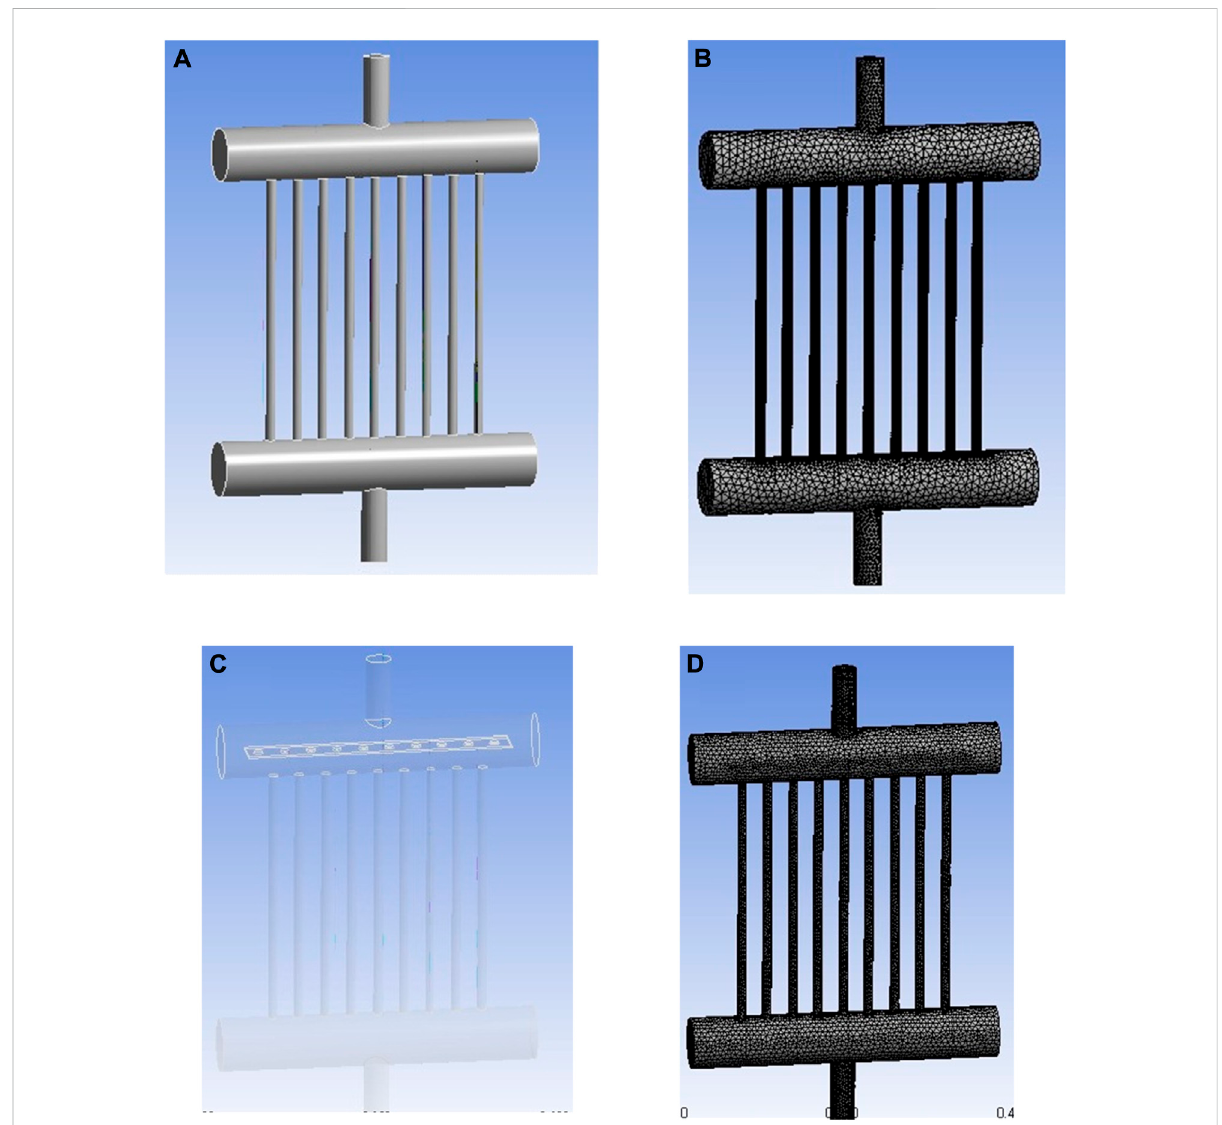
FIGURE 3 Geometry and mesh of header tube assemblies. (A) Geometry of the design without a distributor. (B) Mesh for the design without a distributor. (C) Geometry of the design with a distributor (D) Mesh for the design without a